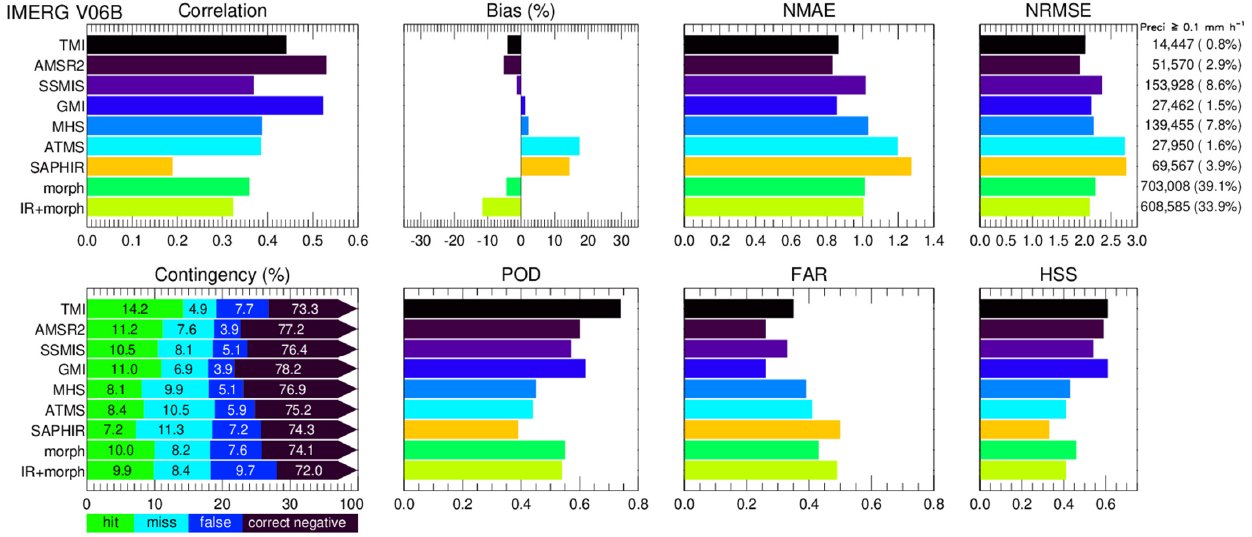
Figure 6. Same as Figure 5 but for IMERG